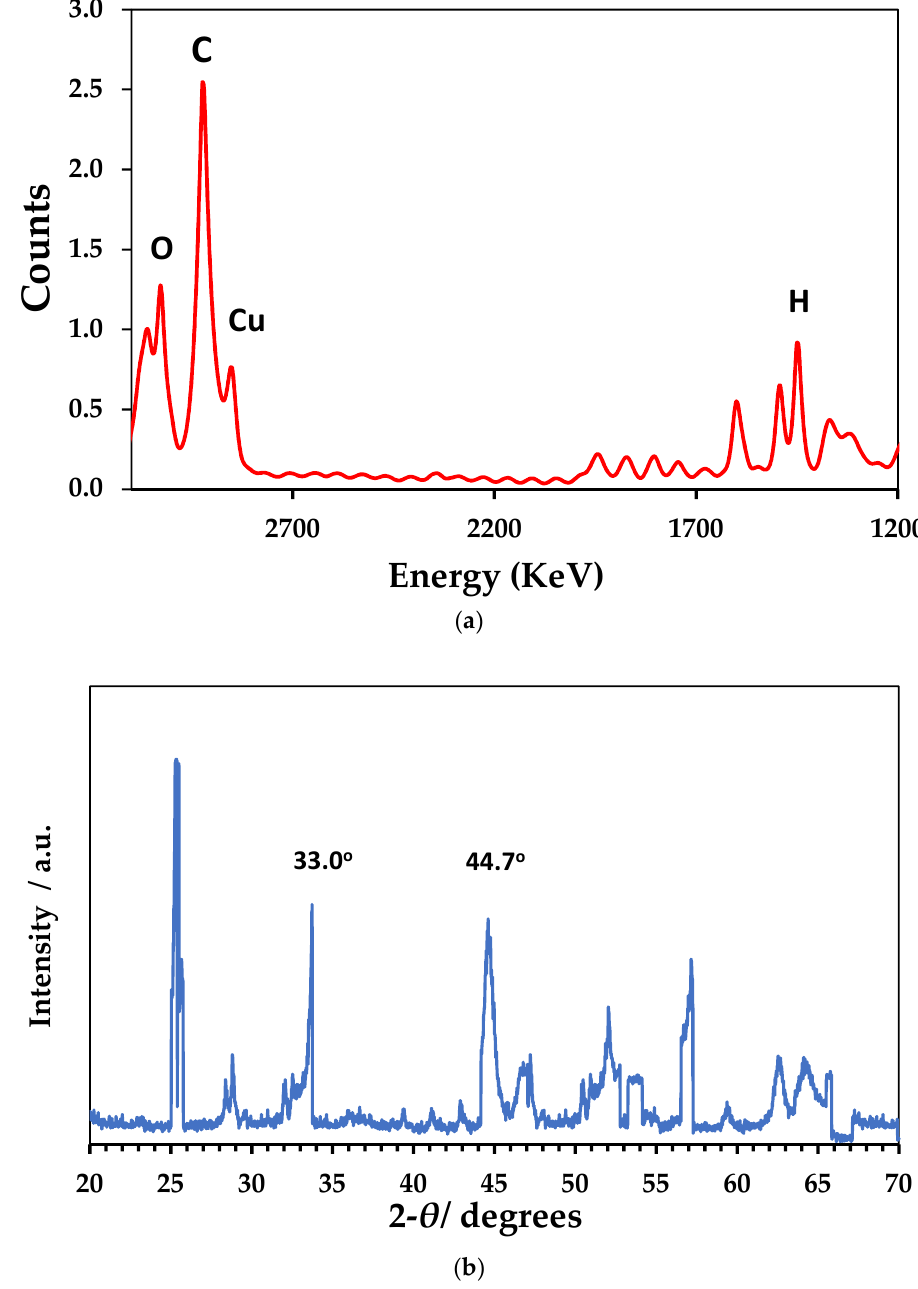
Figure 2. ( a ) EDX and ( b ) XRD spectra of graphene oxide. Table 3. Mixture proportion of specimens (kg/m 3 ).